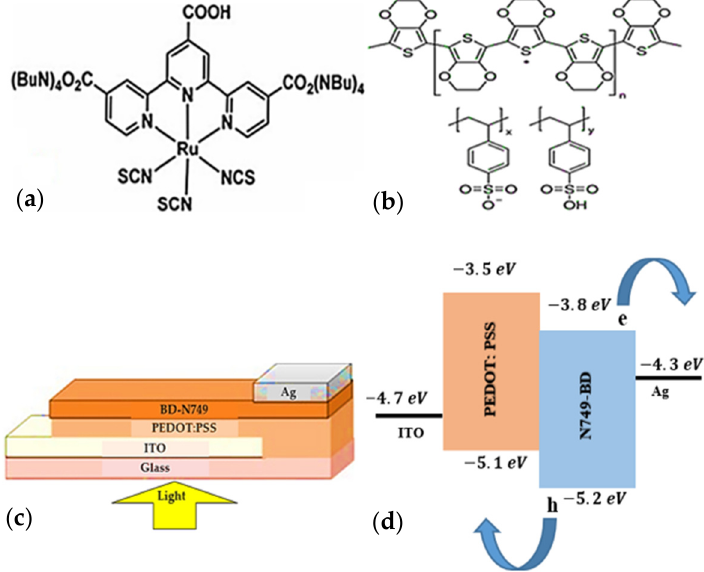
Figure 1. Molecular structure of ( a ) N749-BD and ( b ) PEDOT:PSS; ( c ) architecture of fabricated ITO/PEDOT:PSS/N749-BD/Ag solar cell; and ( d ) energy level diagram of the materials used in the device.